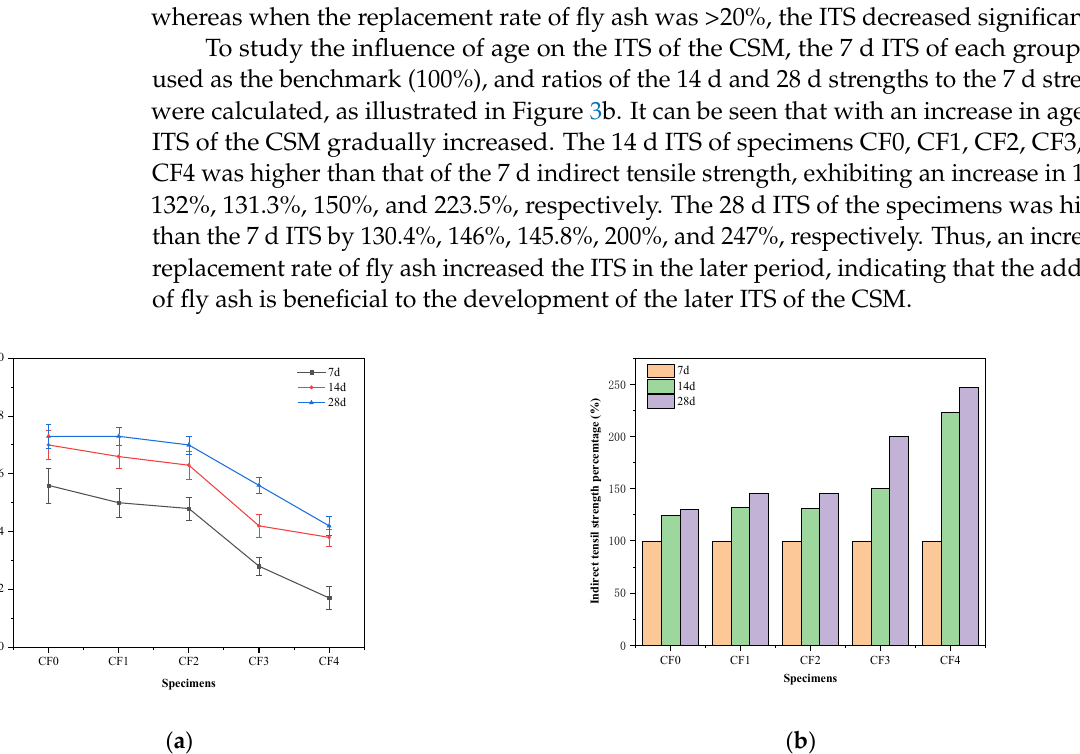
( b ) Figure 2. ( a ) UCS of the CSM with 100% RMA under different fly ash replacement rates and ( b ) the ratio of UCS at different